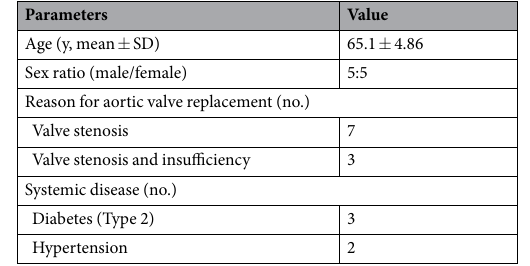
Table 1. Demographic characteristics of the patients (n =